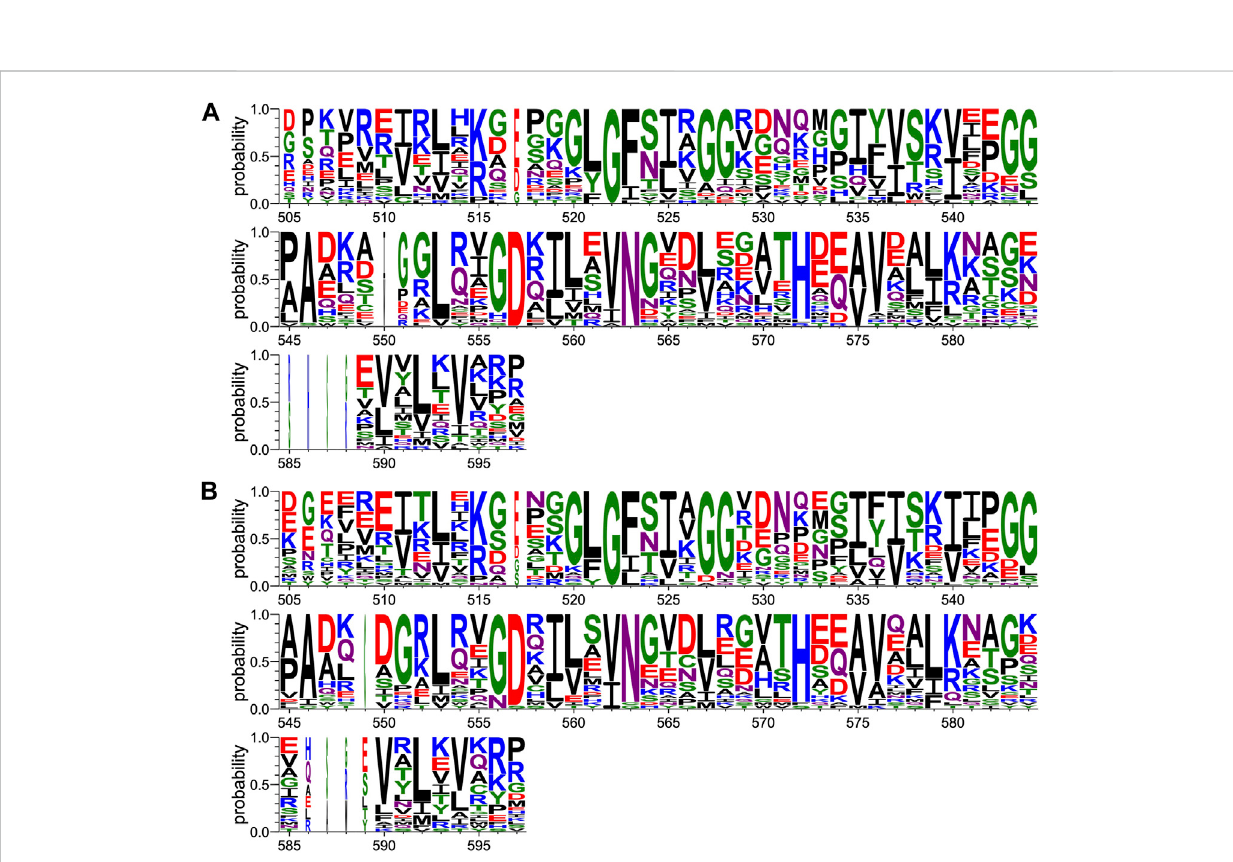
FIGURE 6 Comparison of PDZ domain sequence conservations recruited by PBM-p38 γ and PBM-HBc. The result is displayed using a logo representation (Crooks et al., 2004), where the height of each residue one-letter code translates to its conservation at the corresponding position of the PTPN3-PDZ numbering in the sequence alignment. Sequence logo showing the sequence conservation of PDZ domains recruited during holdup experiment by (A) PBM-p38 γ and (B) by